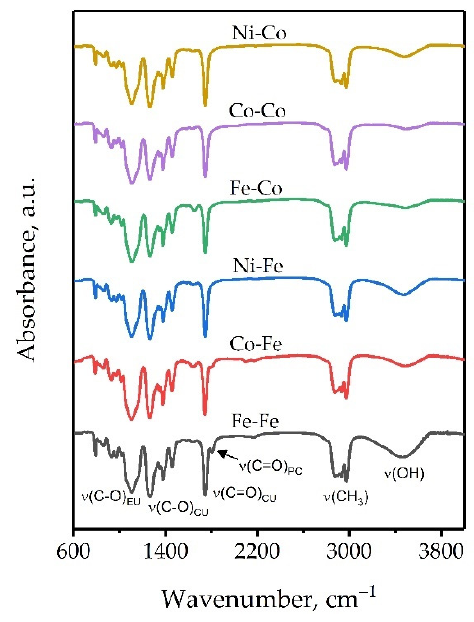
Figure 10. FT-IR spectra of products of CO 2 /PO copolymerization.